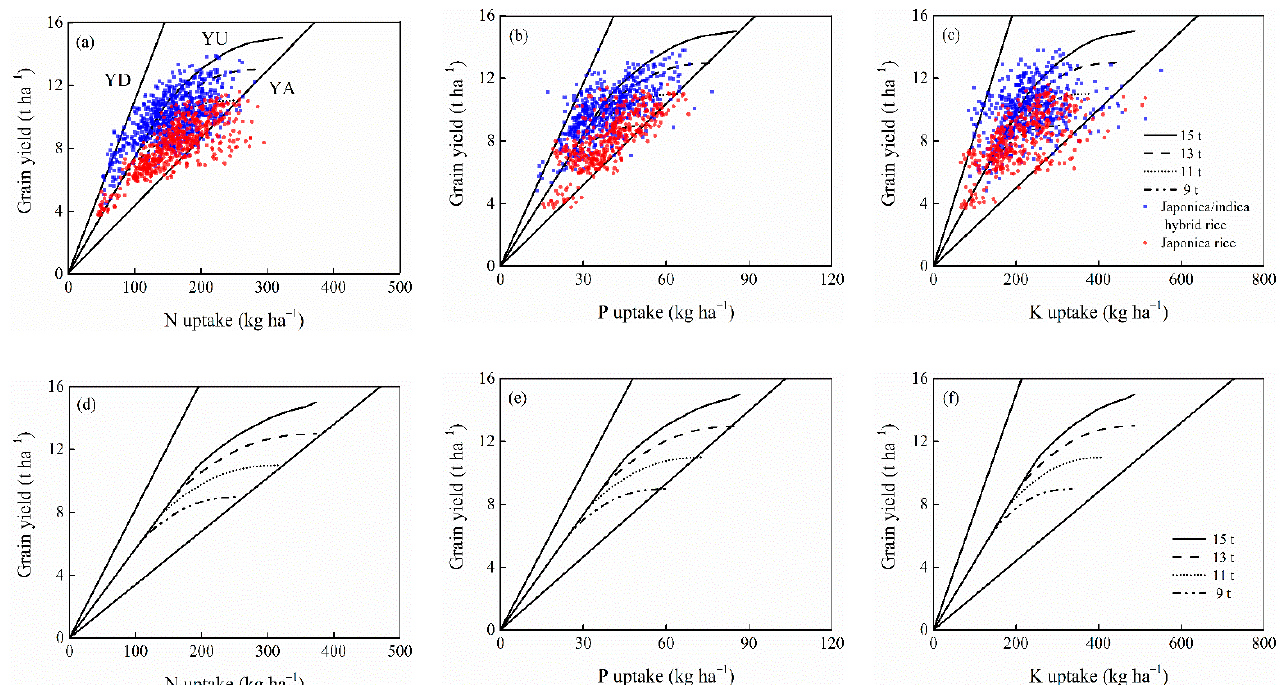
Figure 6. Relationship between grain yield and nutrient uptake in total above-ground plant dry matter under different yield potentials simulated by the QUEFTS model for japonica/indica hybrid rice ( a – c ) and japonica rice ( d – f ). YD, YU, and YA represent the maximum dilution, balanced uptake of nutrient in plant dry matter, and maximum accumulation, respectively. The yield potential ranged from 9 to 15 t ha − 1 .